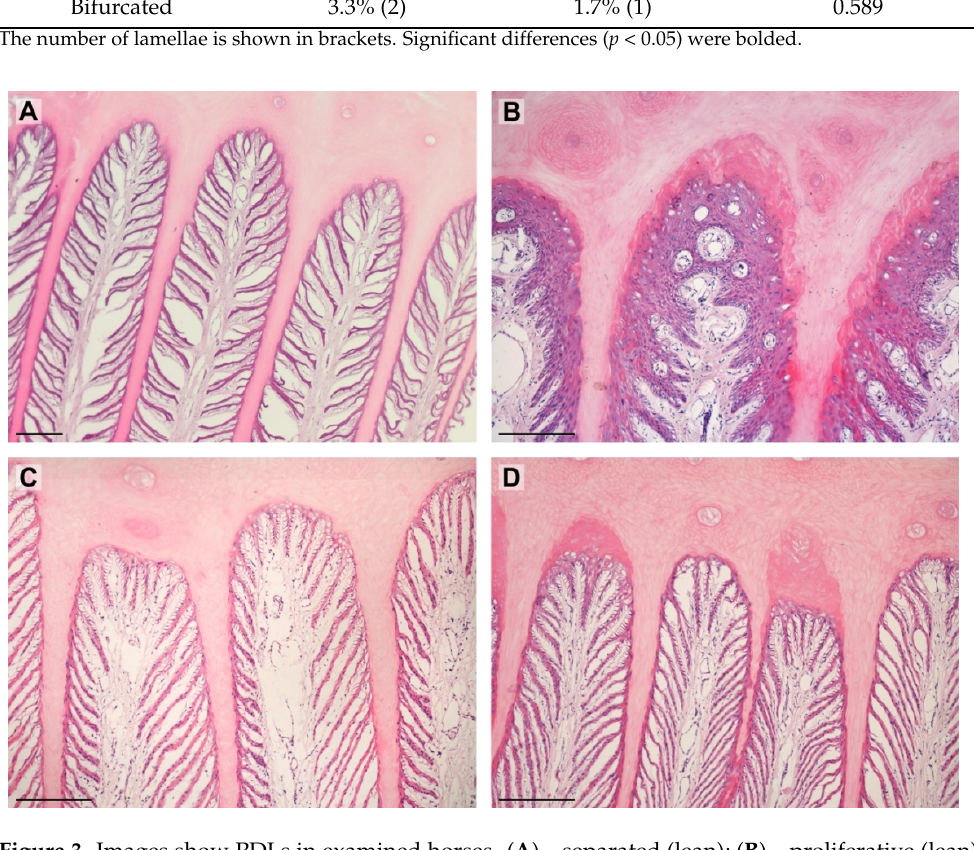
Table 3. Shapes of SELs in examined groups of horses.